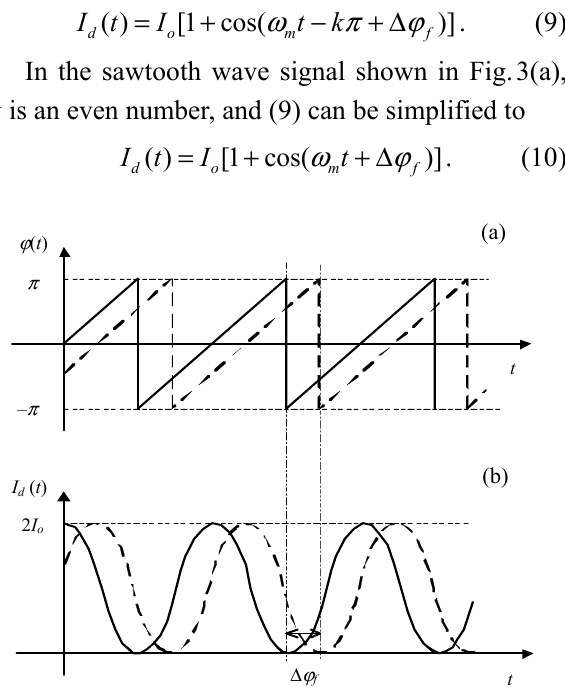
Fig. 3 Relationship between the modulated signal and the detected light